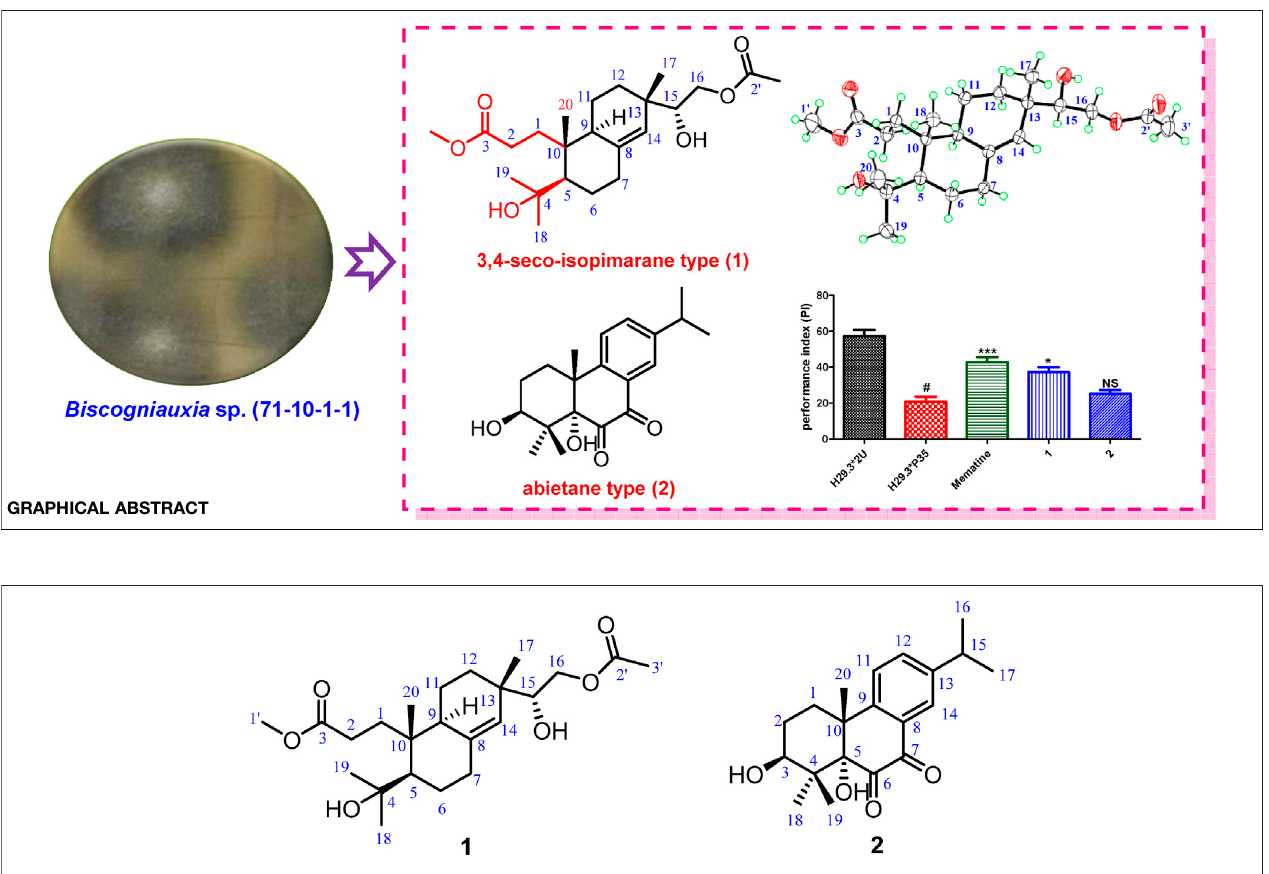
FIGURE 1 | Chemical structures of 1 –